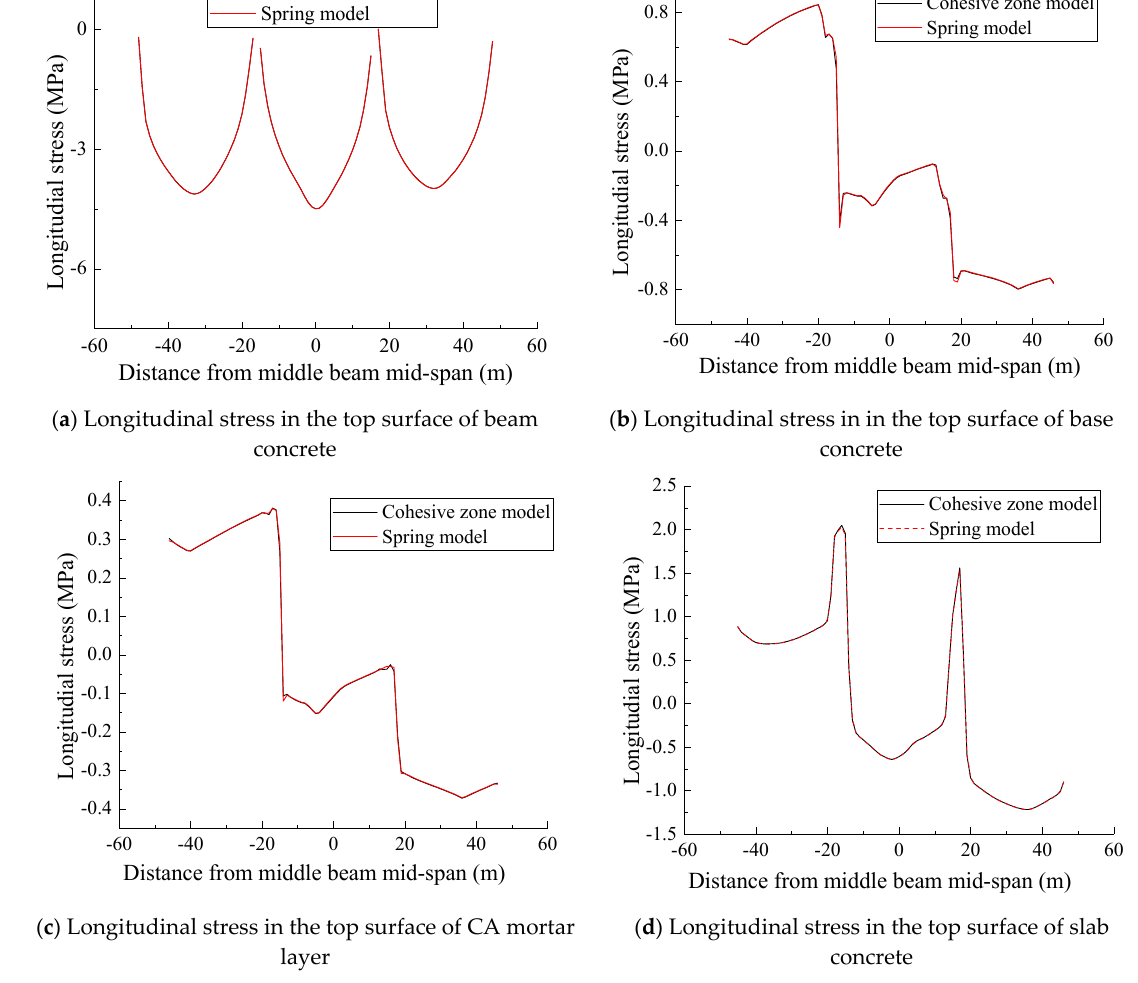
Figure 16. Longitudinal stress of structural layers with the different interfaces bond model under static load. Table 7. Cohesion and spring model comparison.